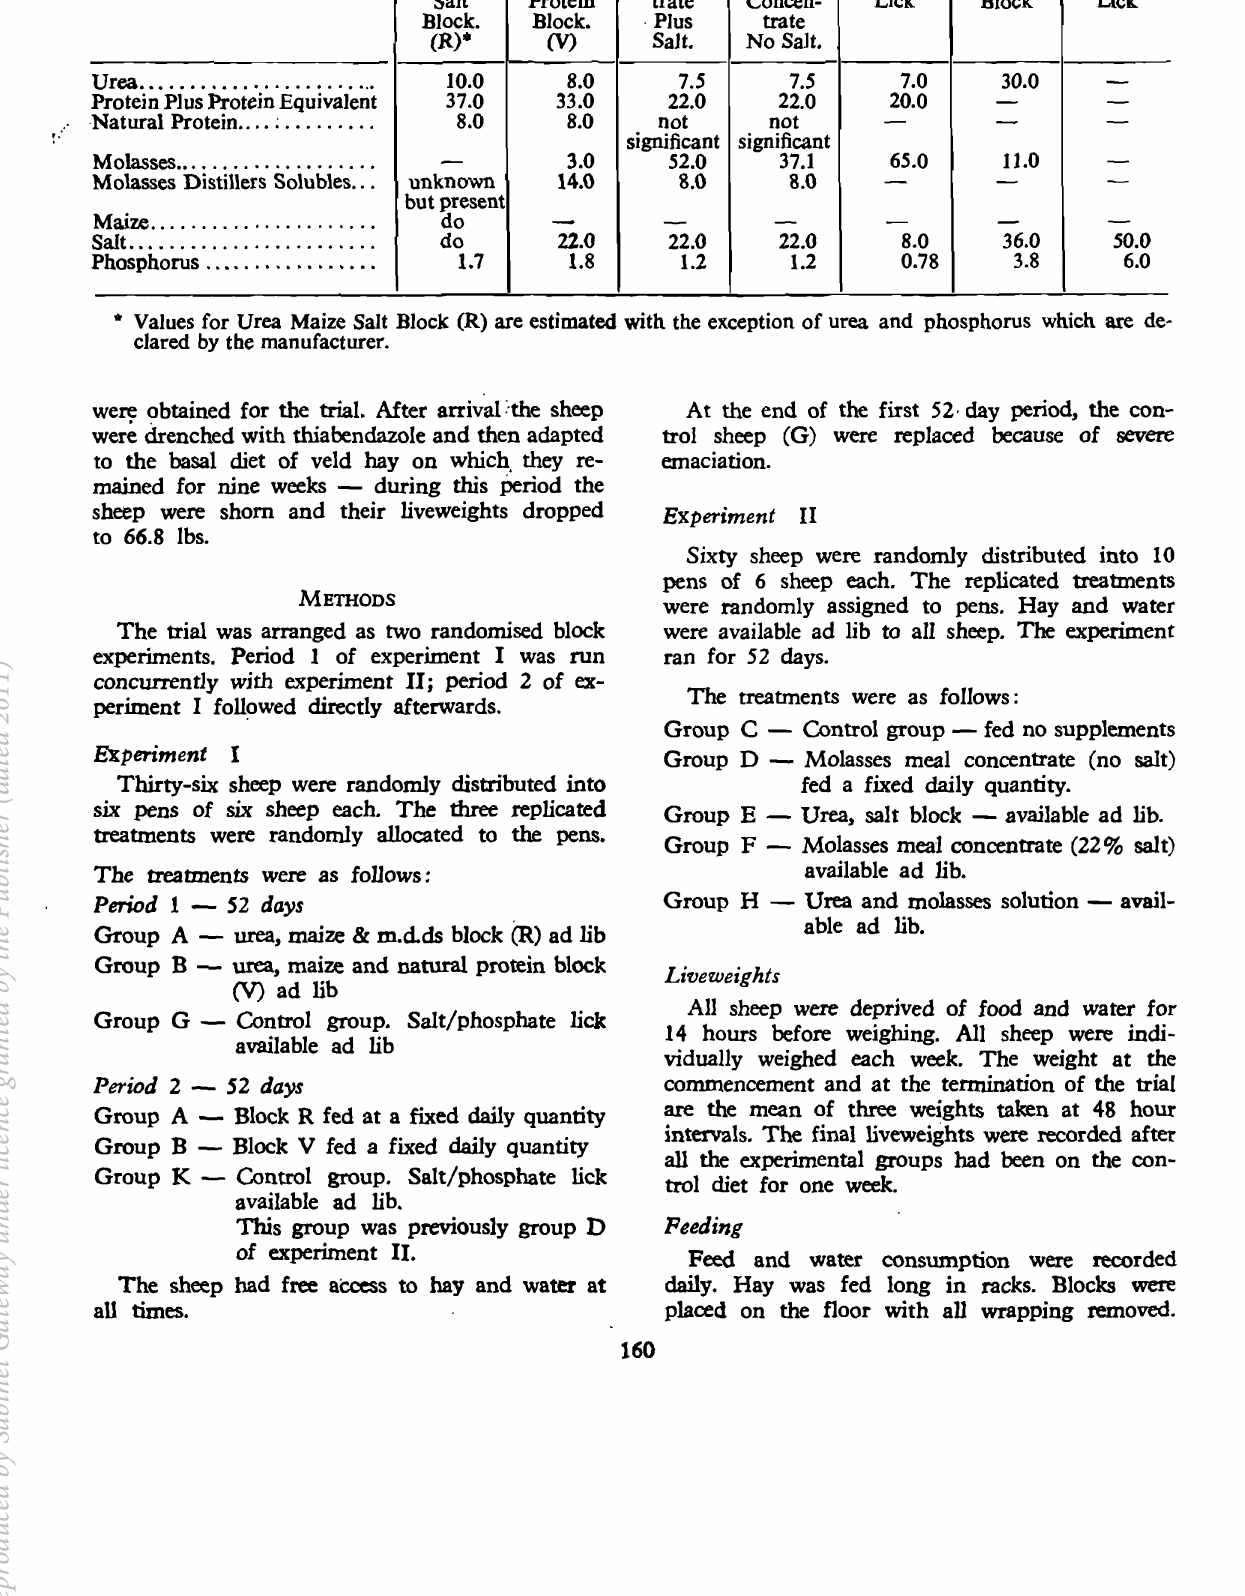
TABLE I.-THEORETICAL COMPOSl'nON OP PEED SUPPLEMBNTS PI!R CENT.